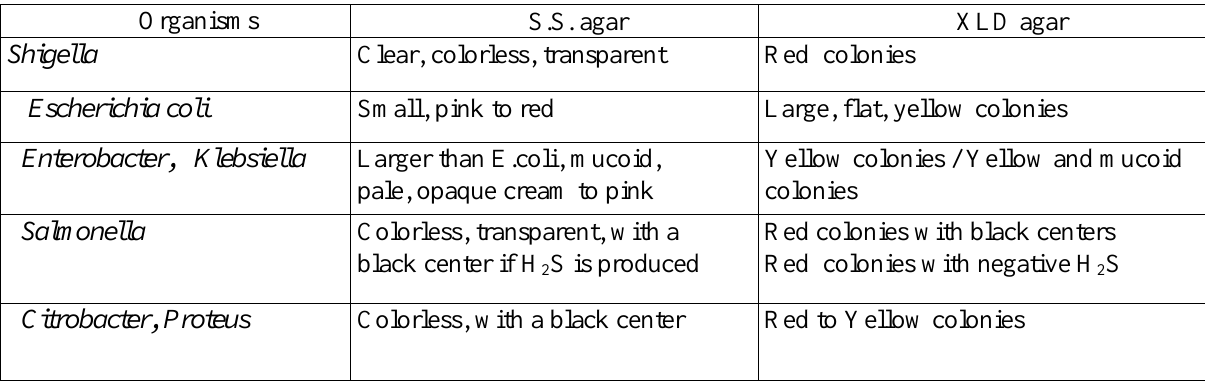
Table 1: Cultural characteristics of selective and differential media: